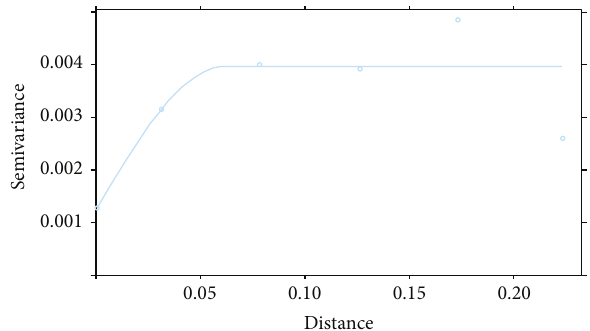
Figure4:Semivariogramforestimatedgroundwaterrechargeinthe study area.